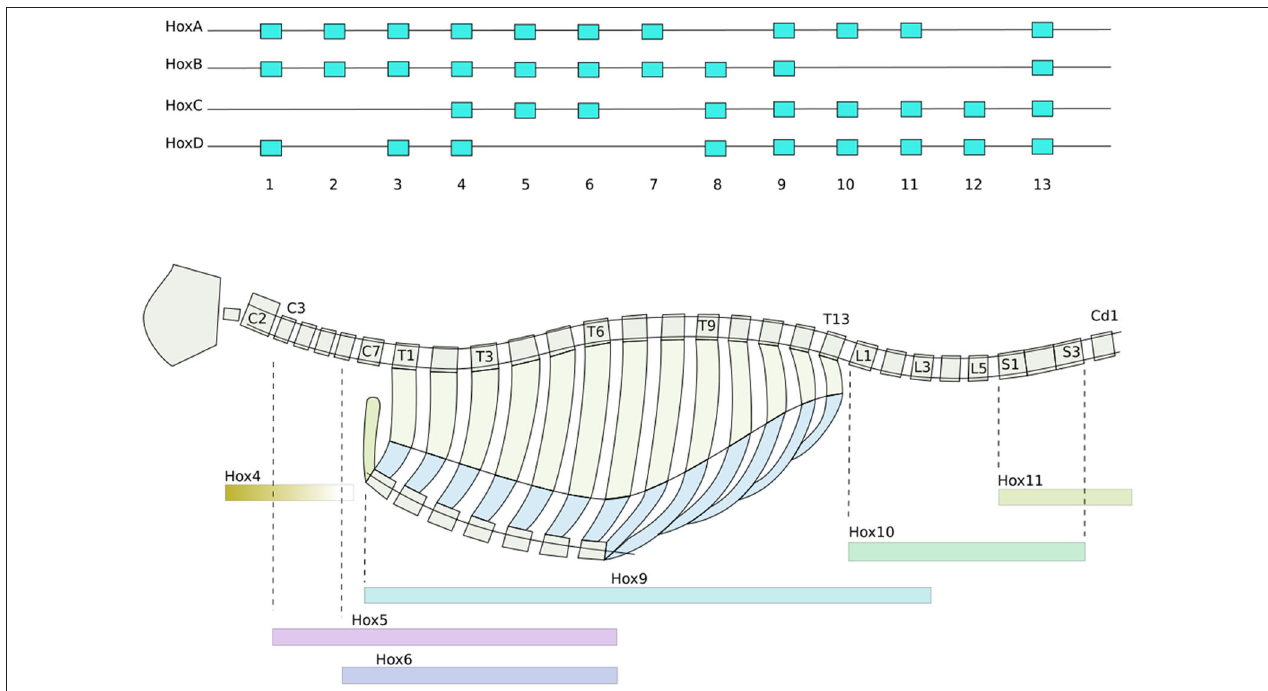
FIGURE 1 | Hox gene patterning of the axial skeleton. From drawn from data in Baker et al. (2008) and Wellik (2007). (Top) The sequential ordering of the Hox genes preserved across all four duplicates of the cluster. Activation and deactivation of the Hox genes spreads progressively along the clusters, concurrent with the formation of the somites ( Box 2 ). Consequently different groups of somites have different combinations of Hox genes activated. (Bottom) How Hox genes determine how the tissues grow, producing the characteristic types of vertebrae, collar bones, ribs, sternal manubrae, sacrum, and pelvis of the axial skeleton. Color bars indicate which hox genes are essential for each section. Each vertebral segment corresponds to a somite produced in Figure 2 .